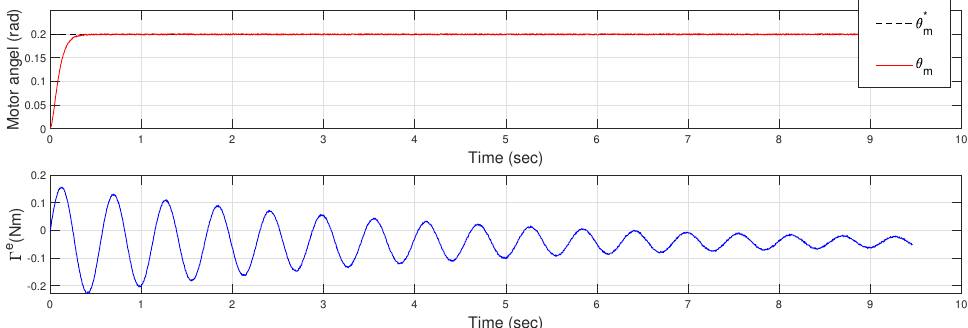
Figure 7. Measurement of the strain gauges when a step command is applied to the inner loop.